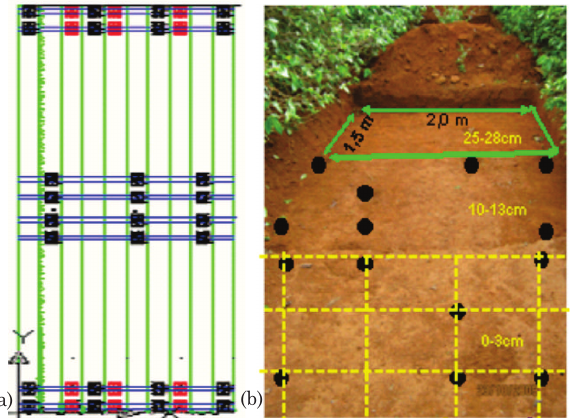
Figura 1. (a) Distribuição das trincheiras na lavoura cafeeira, em que a cor preta indica sub-regiões amostradas; a verde, as linhas do cafeeiro; e a vermelha, as sub-regiões de futuras amostragens. (b) Trincheira com os três degraus, que correspondem às camadas de amostragem de 0,00, 0,10 e 0,25